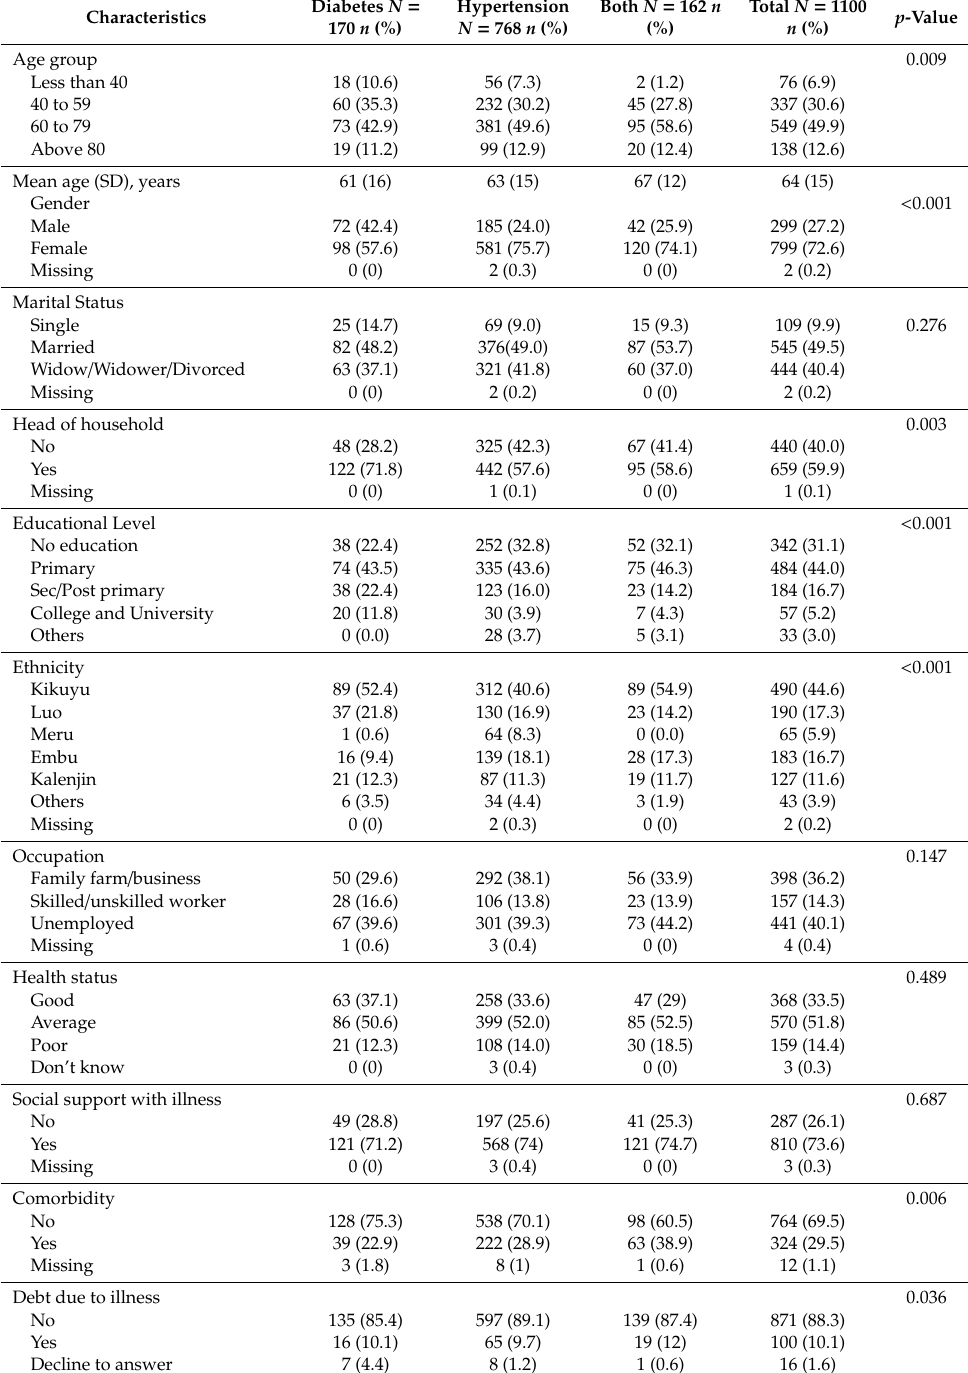
Table 1. Socio-demographics of the respondents according to disease